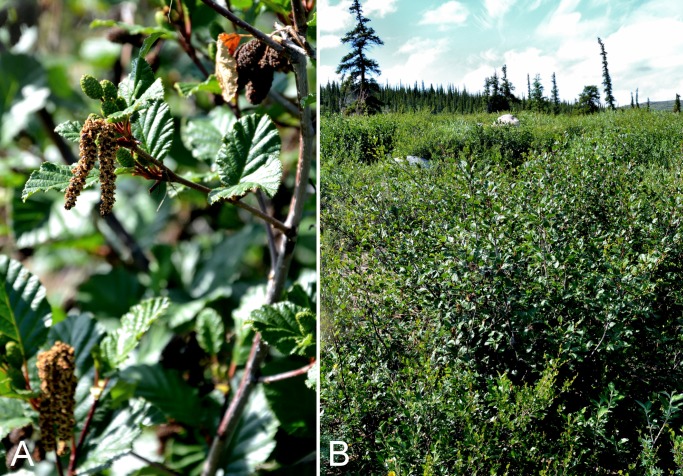
Alnus alnobetula.(A) Staminate and pistillate catkins, Saarela et al. 3598. (B) Habit, Saarela et al. 3598. Photographs by P. C. Sokoloff.